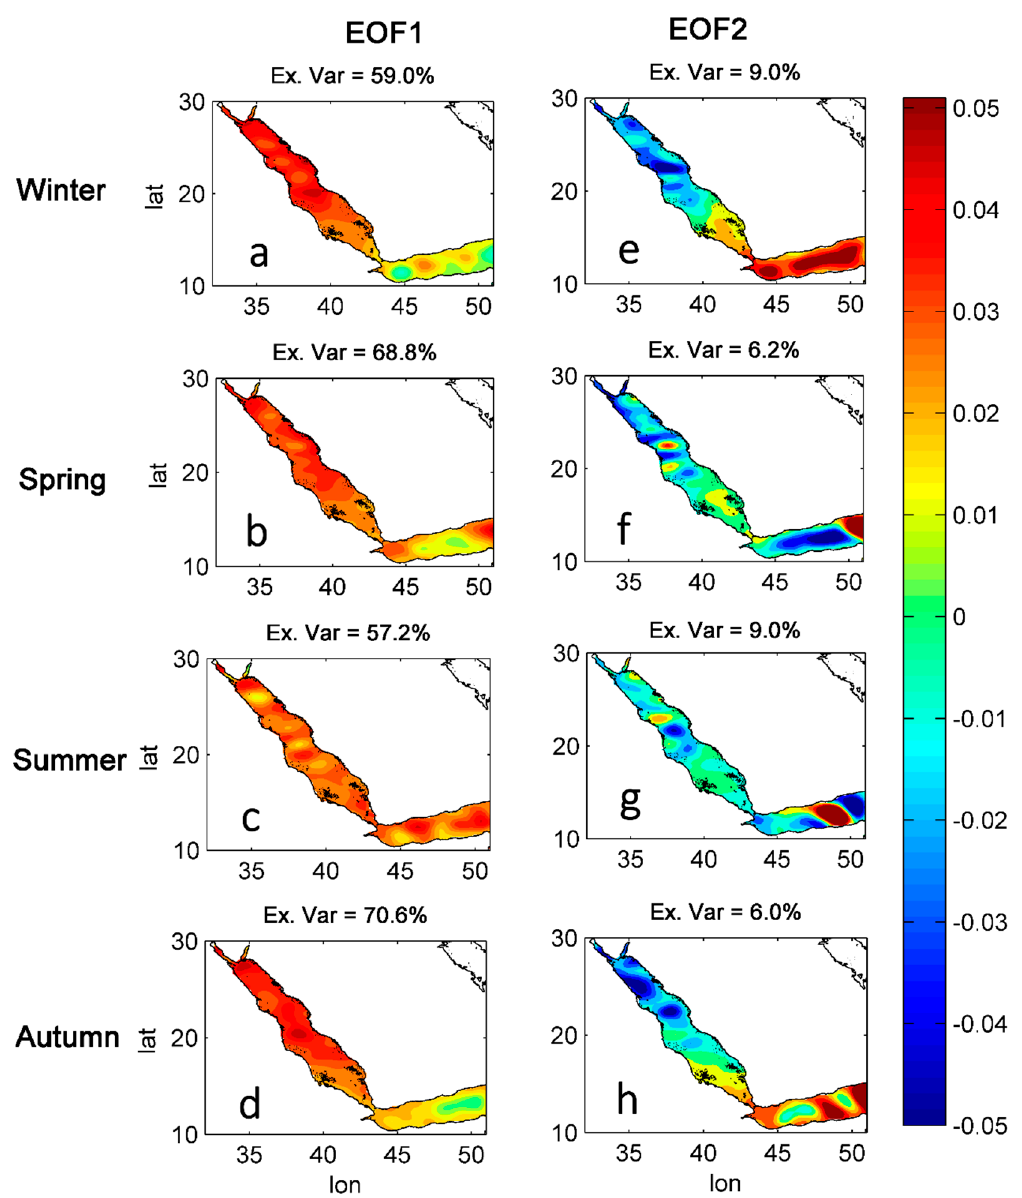
Figure 3. Spatial patterns of the EOF1 ( a – d ) and EOF2 modes ( e – h ) of the SLA for the four seasons.